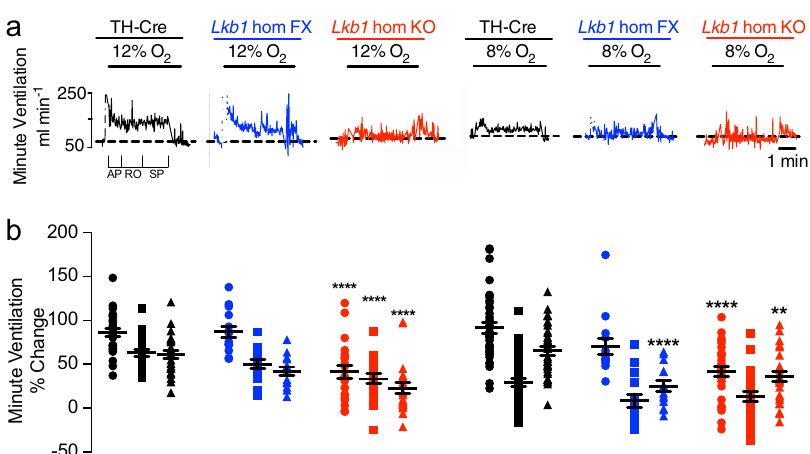
Fig. 5 Mice hypomorphic for LKB1 exhibit an attenuated hypoxic ventilatory response measured by unrestrained plethysmography. a Example records of minute ventilation versus time. b Dot plots of mean ± SEM for % change in minute ventilation at the peak of the Augmenting Phase (AP, ~30 s), after Roll Off (RO, ~100 s) and during the plateau of the Sustained Phase (SP, ~300 s) of the ventilatory response to 12% and 8% O 2 for TH-Cre (black; 12% O 2 , n = 25 independent experiments; 8% O n = 37 independent experiments), Lkb1 homozygous fl oxed ( Lkb1 hom Fx, blue; 12% O 2 , experiments; 8% O 2 , n = 15 independent experiments) and conditional Lkb1 homozygous knockout mice ( Lkb1 hom KO, red; n = 22 independent experiments; 8% O 2 , n = 30 independent experiments). ** = p < 0.01; **** = p <